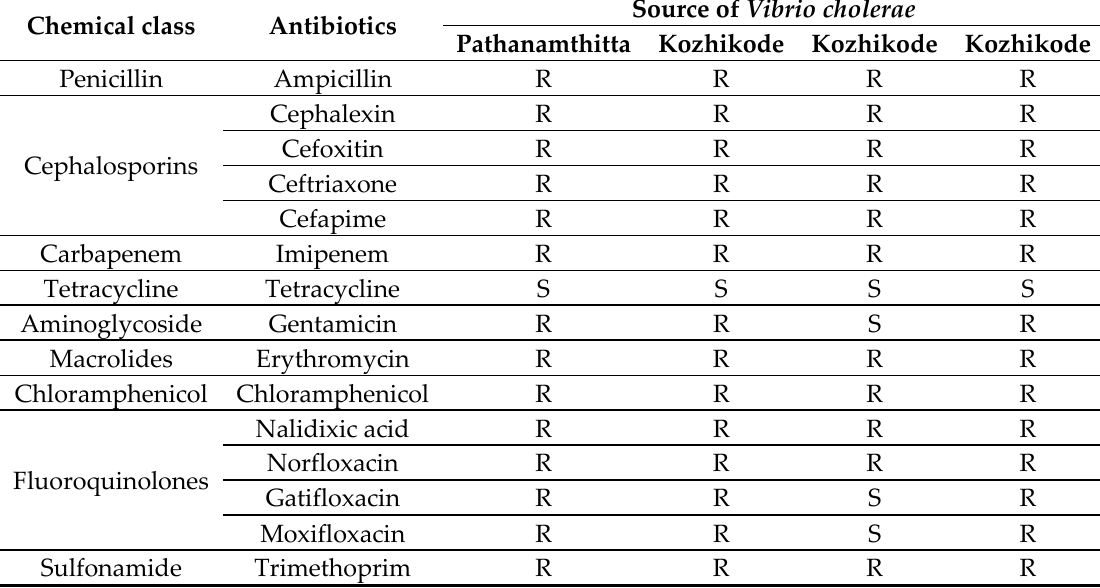
Table 1. Antibiotic resistance profile of clinical Vibrio cholerae